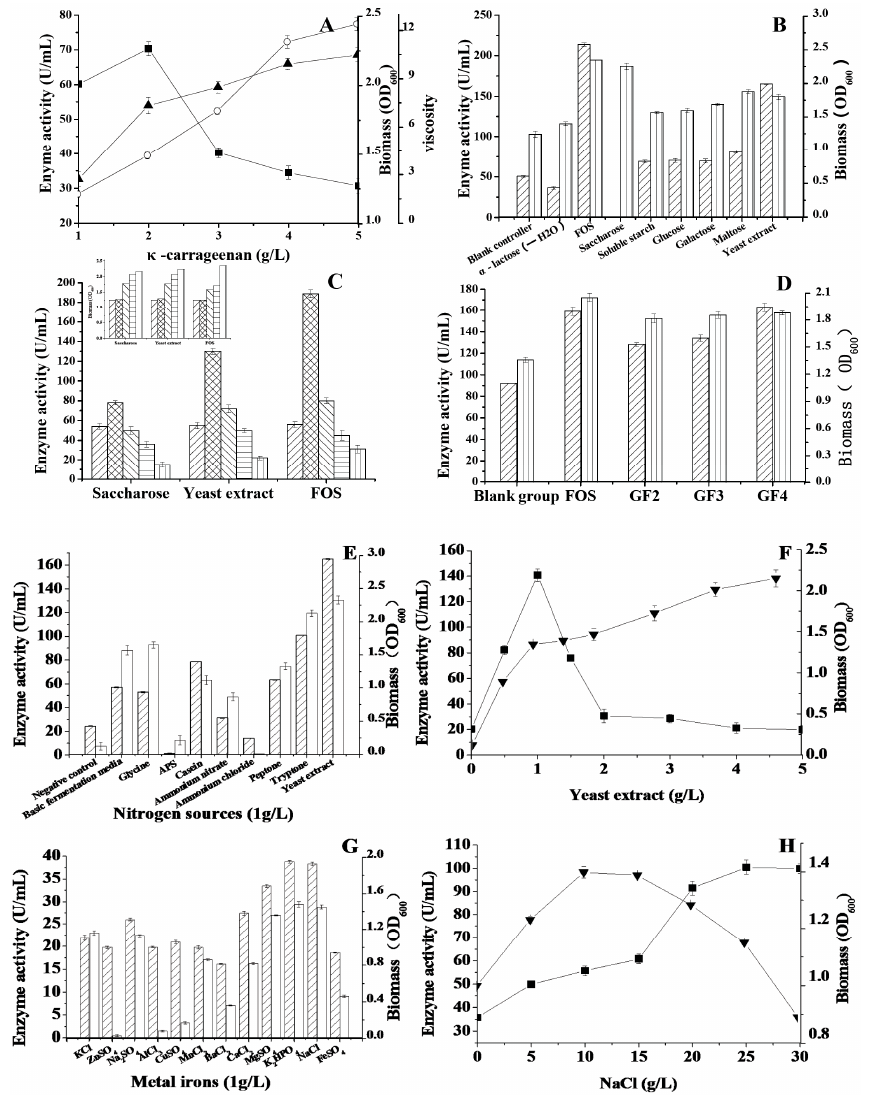
Figure 3. ( A ) Effects of κ -carrageenan on κ -carrageenase and biomass. █ Enzyme activity, ▼ Biomass, ○ Viscosity; ( B ) Effects of other carbon sources on κ -carrageenase and biomass, including α -lactose (-H 2 O), FOS, saccharose, soluble starch, glucose, galactose, maltose and yeast extract with the concentration of 1 g/L, respectively. Enzyme activity, Biomass; ( C ) Effects of saccharose, yeast extract and FOS on κ -carrageenase and biomass (the small figure on the left). 0 g/L, 1 g/L, 2 g/L, 3 g/L, 4 g/L; ( D ) Effects of inducers on κ -carrageenase and biomass, including FOS, GF2, GF3, GF4 with the concentration of 1 g/L. Enzyme activity, Biomass; ( E ) Effects of nitrogen sources on κ -carrageenase and biomass, the test nitrogen sources with final concentration of 1 g/L Enzyme activity, Biomass; ( F ) Effects of yeast extract on κ - carrageenase and biomass, █ Enzyme activity, ▼ Biomass; ( G ) Effects of metal irons on κ - carrageenase and biomass, all of the metal irons with the concentration of 0.2 g/L, Enzyme activity; Biomass; ( H ) Effects of NaCl on κ -carrageenase and biomass, █ Enzyme activity, ▼ Biomass.